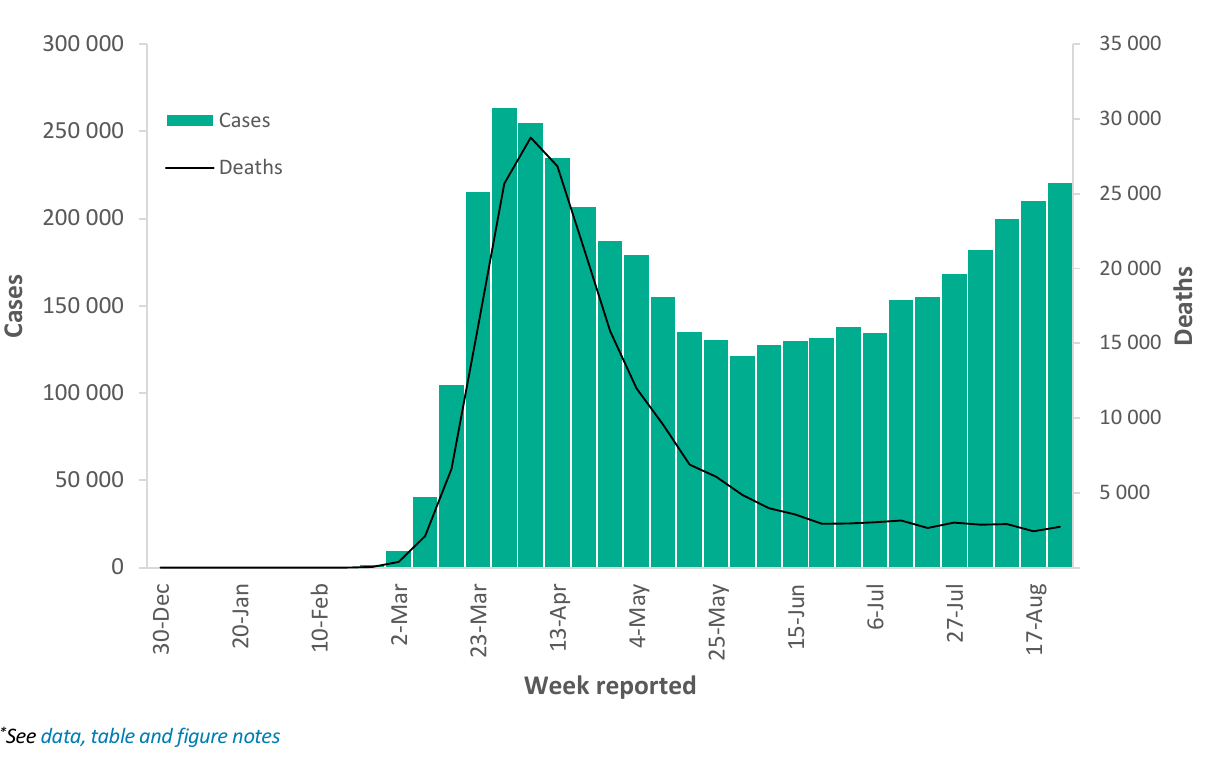
Figure 6: Number of COVID-19 cases and deaths reported weekly by European Region, data as of 30 August 2020